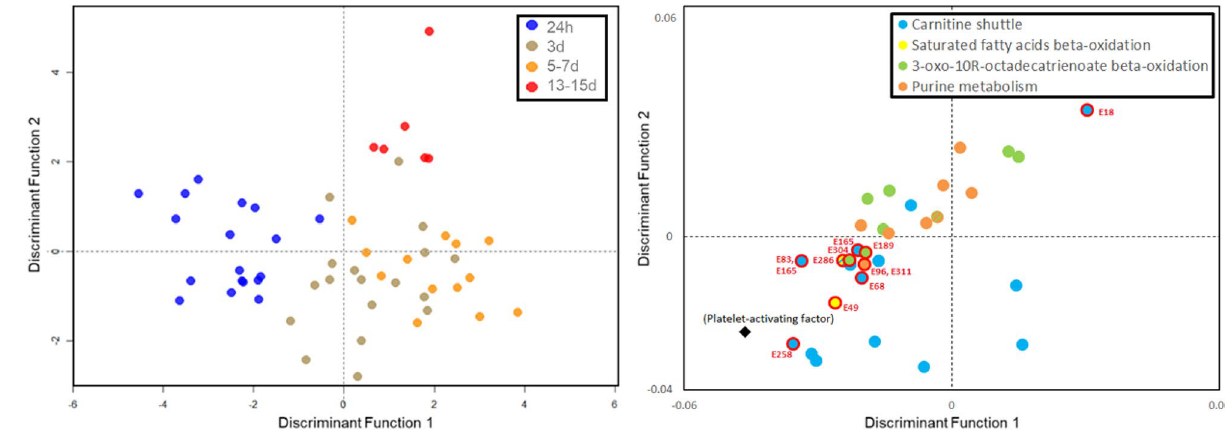
Figure 3. (Left) PC-DFA scores plot with blood plasma samples ( n = 56) coloured by timepoint groups and (right) loadings plot showing EIDs from the molecular network analysis coloured by biochemical pathway. The significant EIDs listed in Table 3 are encircled in red. Details of all EIDs are listed in Table